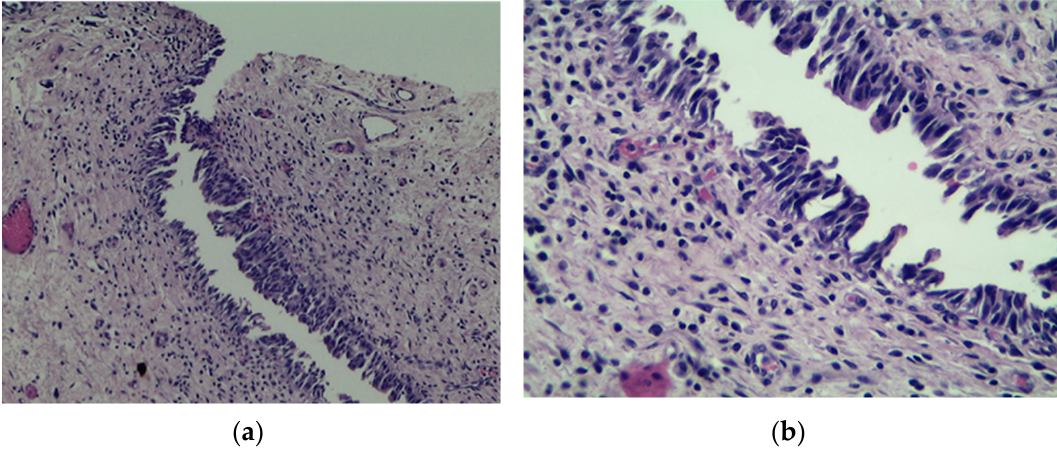
Figure 2. Micropapillary variant of urothelial bladder cancer, H&E stain. A phenomenon associated with dismal prognosis; ( a ) 100×; ( b ) 200×. Courtesy of M. Pyzlak, MD, PhD.